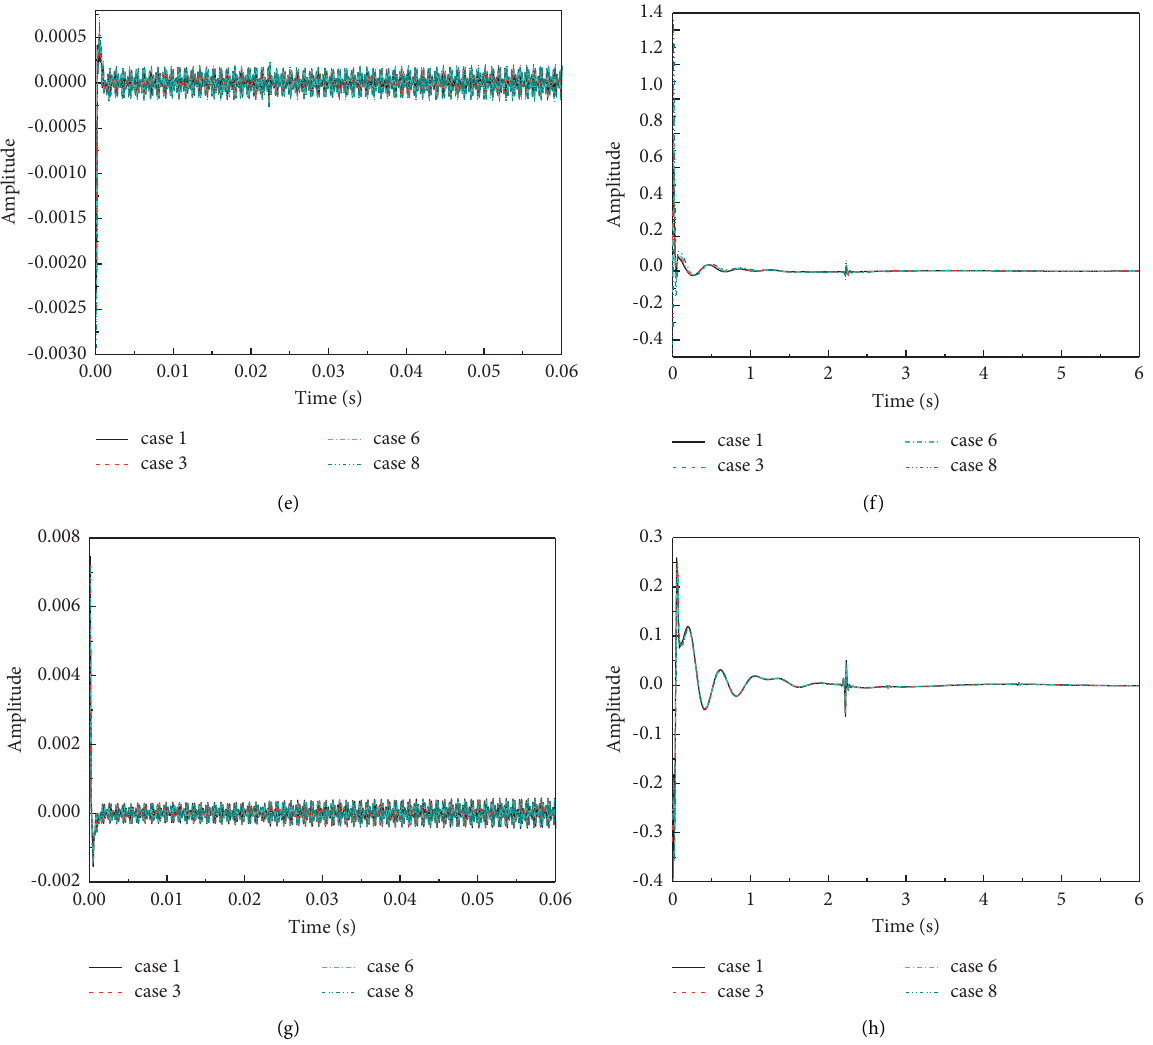
Figure 5: The time history curves of IRF and VIRF of different measuring points (the second time test at excitation point I). Point 1: (a) IRF. (b) VIRF. Point 7: (c) IRF. (d) VIRF. Point 12: (e) IRF. (f) VIRF. Point 25: (g) IRF. (h)